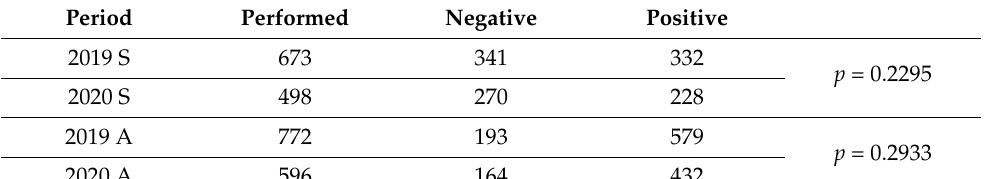
Figure 3. U rine cultures.